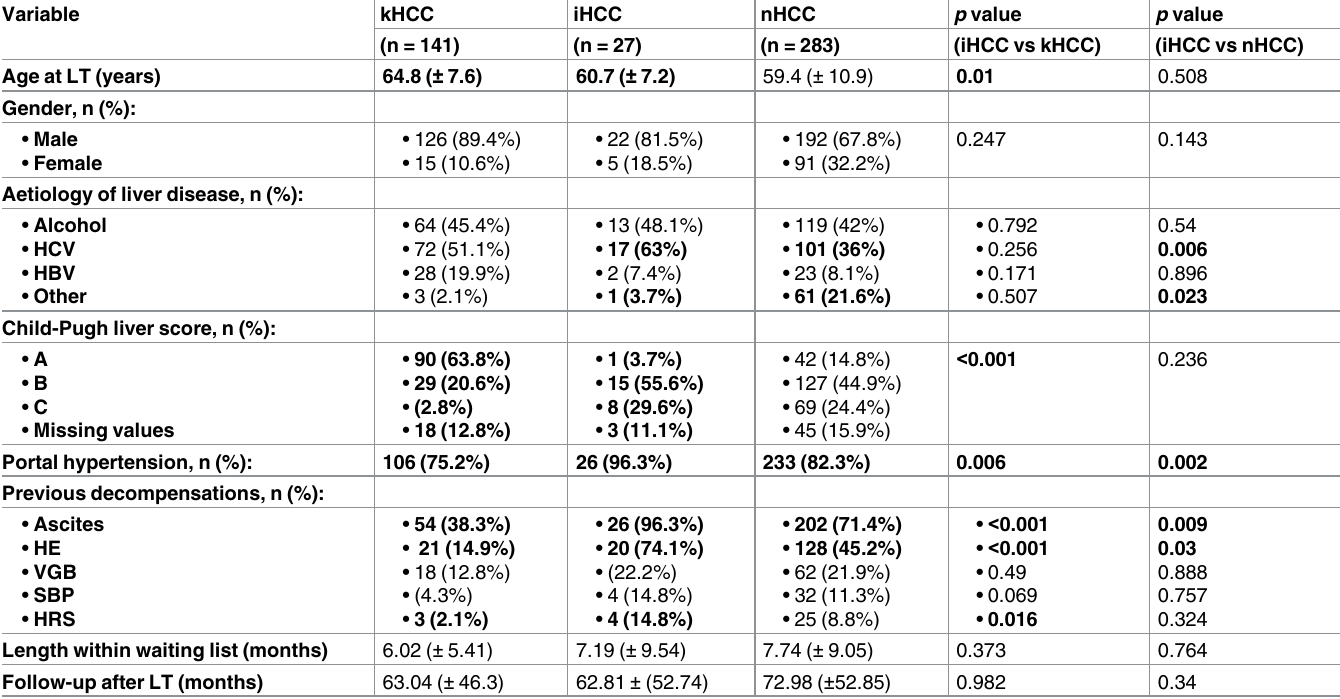
Table 1. Clinical characteristics of 451 consecutive patients who receiveda liver transplantation between January 2000to April 2013. Patients were stratified into previously known hepatocellular carcinoma(kHCC, n = 141), incidentalhepatocellular carcinoma (iHCC, n = 27), and patients without hepatocellular carcinoma (nHCC, n = 283). Continuous variables are presentedas mean ± standard deviation(median and interquartile range for asymmetric distributions). Categorical variablesare displayedas n (%). Statistically significantfindings are highlightedin